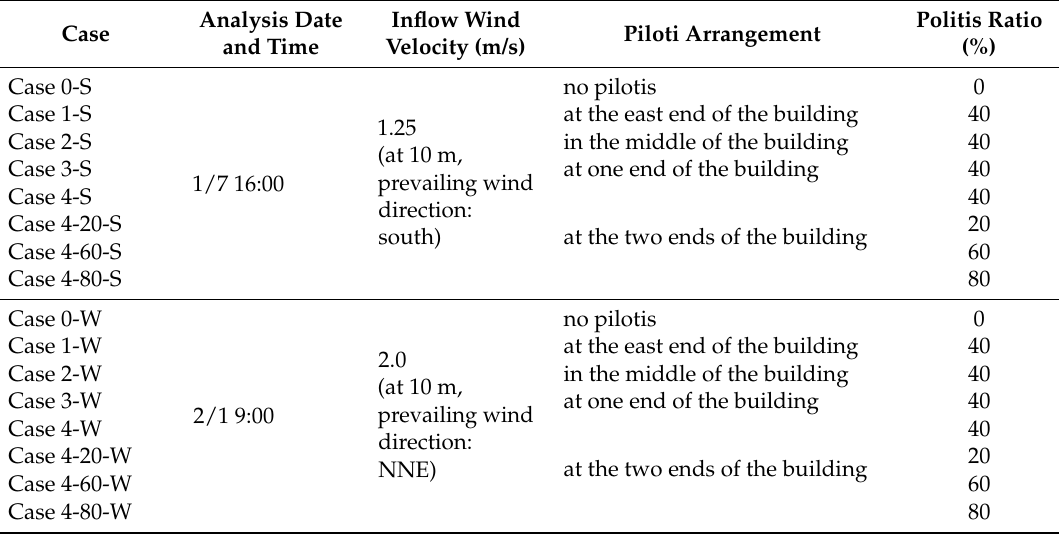
Table 8. The details of the pilotis arrangements analysed in the study area.